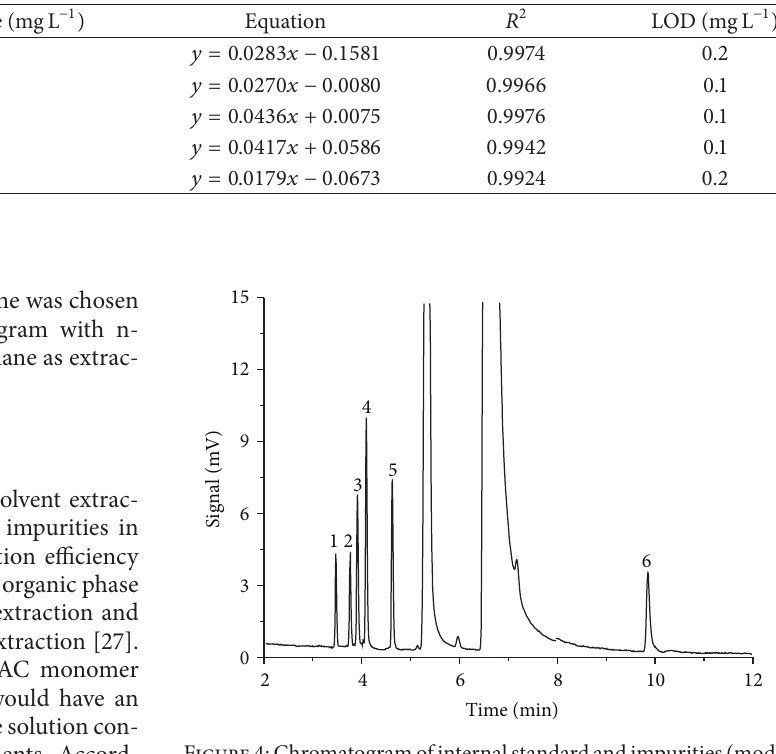
Figure4:Chromatogramofinternalstandardandimpurities(mod- ified PEG-20M capillary column. Peaks: 1, 𝑛 -hexane; 2, dimethy- lamine; 3, allyldimethylamine; 4, allyl chloride; 5, allyl aldehyde; 6, allyl